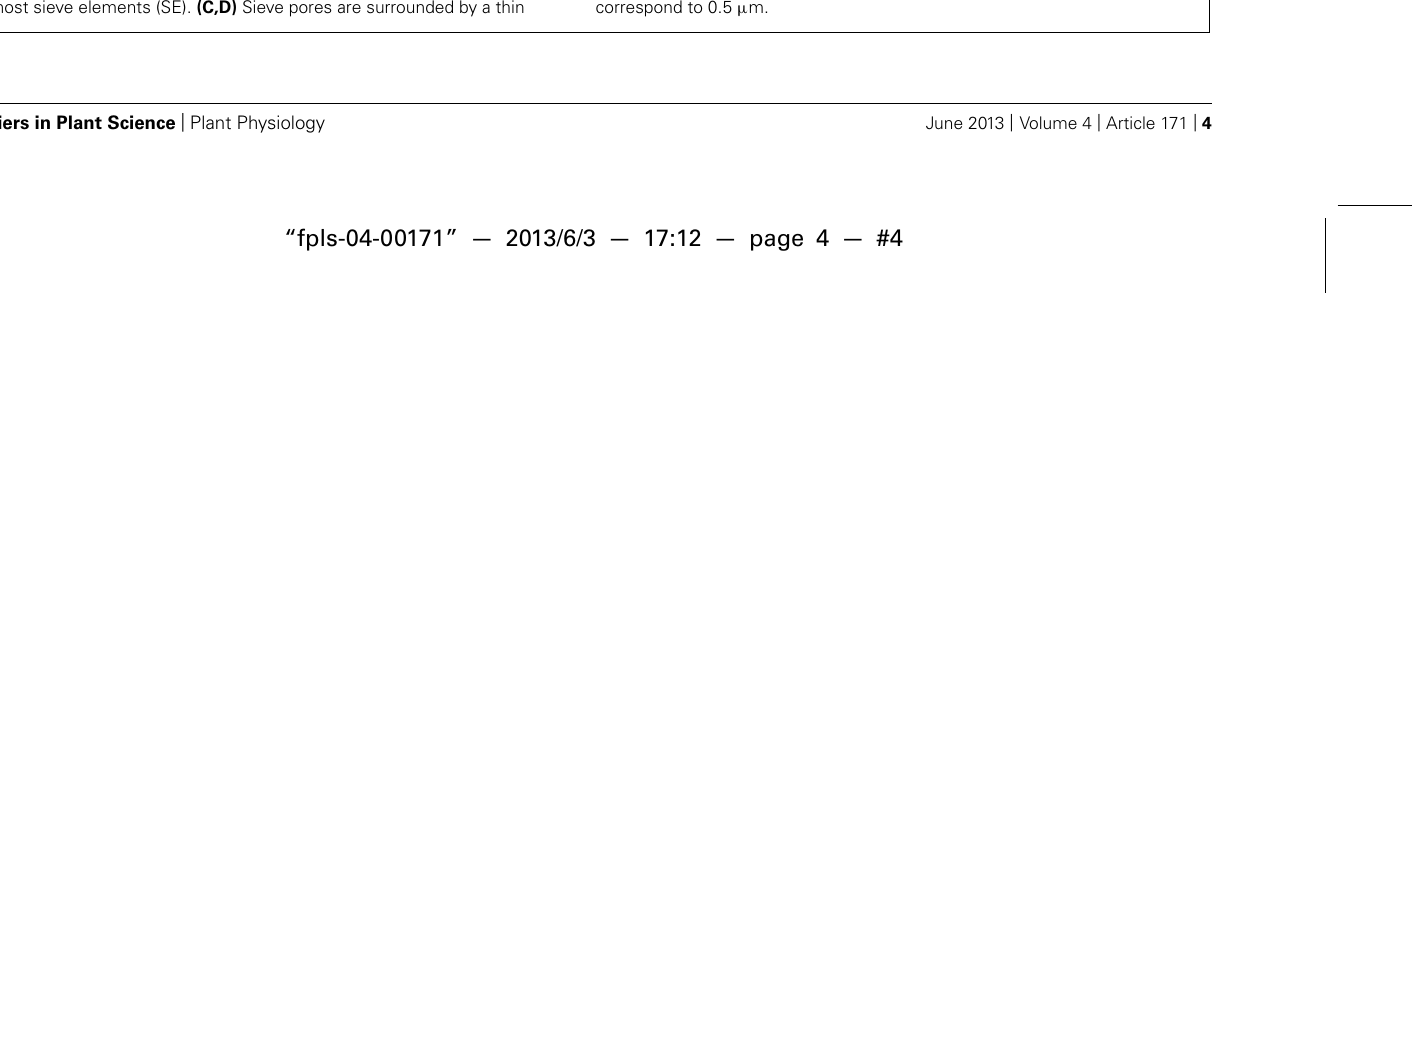
FIGURE 1 |Transmission electron micrographs of leaf tissues from healthy grapevines. (A,B) P-protein (pp) is uniformly dispersed in the lumen of most sieve elements (SE). (C,D) Sieve pores are surrounded by a thin